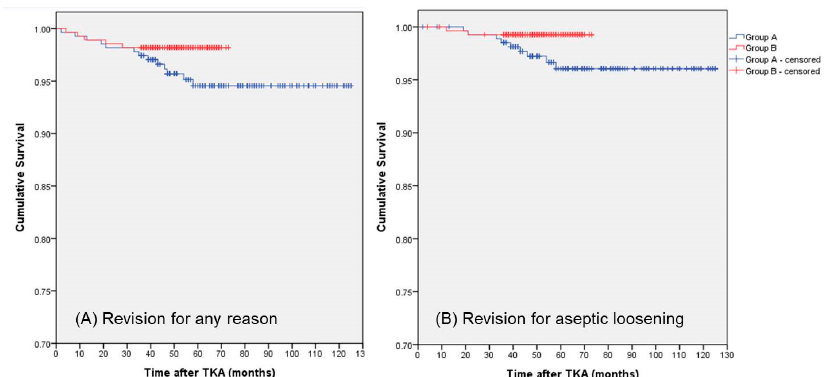
Figure 4. The Kaplan-Meier survival curve with revision ( A ) for any reason or ( B ) for aseptic loosening as endpoint. Patients were categorized into two groups according to the undersurface roughness ( R a ) of the prosthesis used in total knee arthroplasty: R a = 5.0 µ m (Group A) and R a = 11.6 µ m (Group